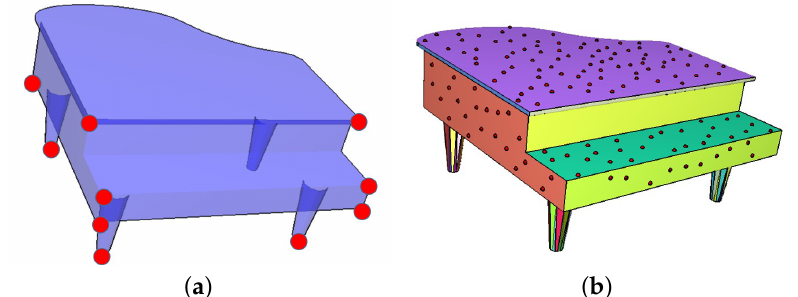
Figure 4. Object model analysis. ( a ) Vertices of the object (red points). ( b ) Contact points sampled on the object surface. The facets segmented by the superimposed segments are denoted by different colors. The contact points on the green surface are removed due to collision between the object and the